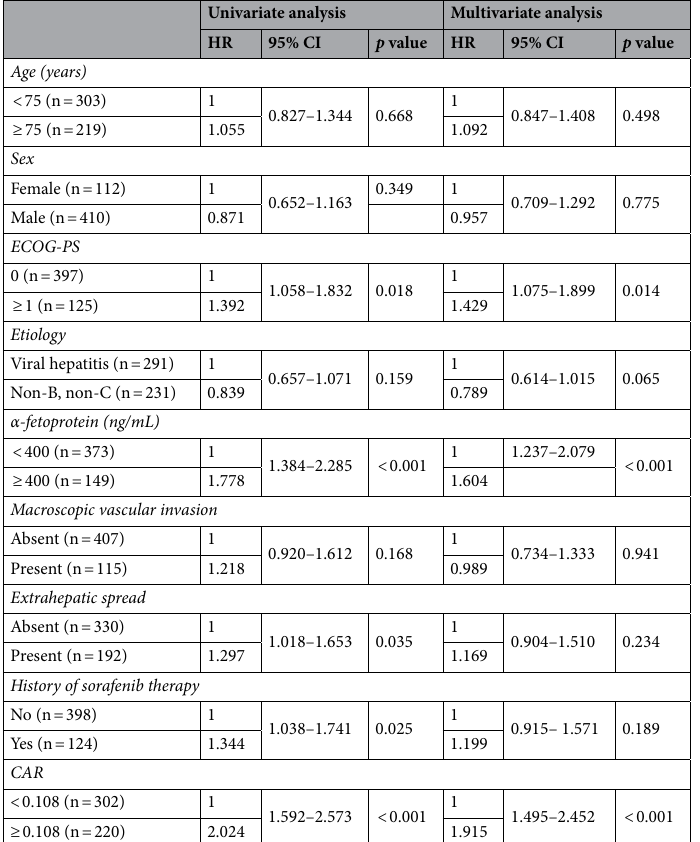
Univariate analysis Multivariate